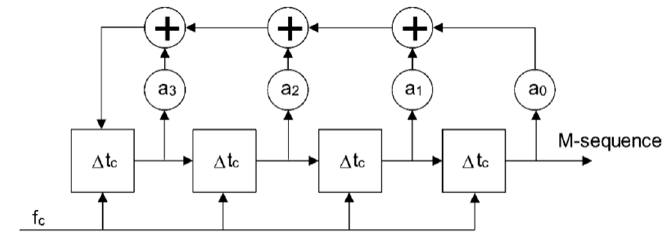
Figure 1. M-sequence generator example for 4th-order M-sequence.